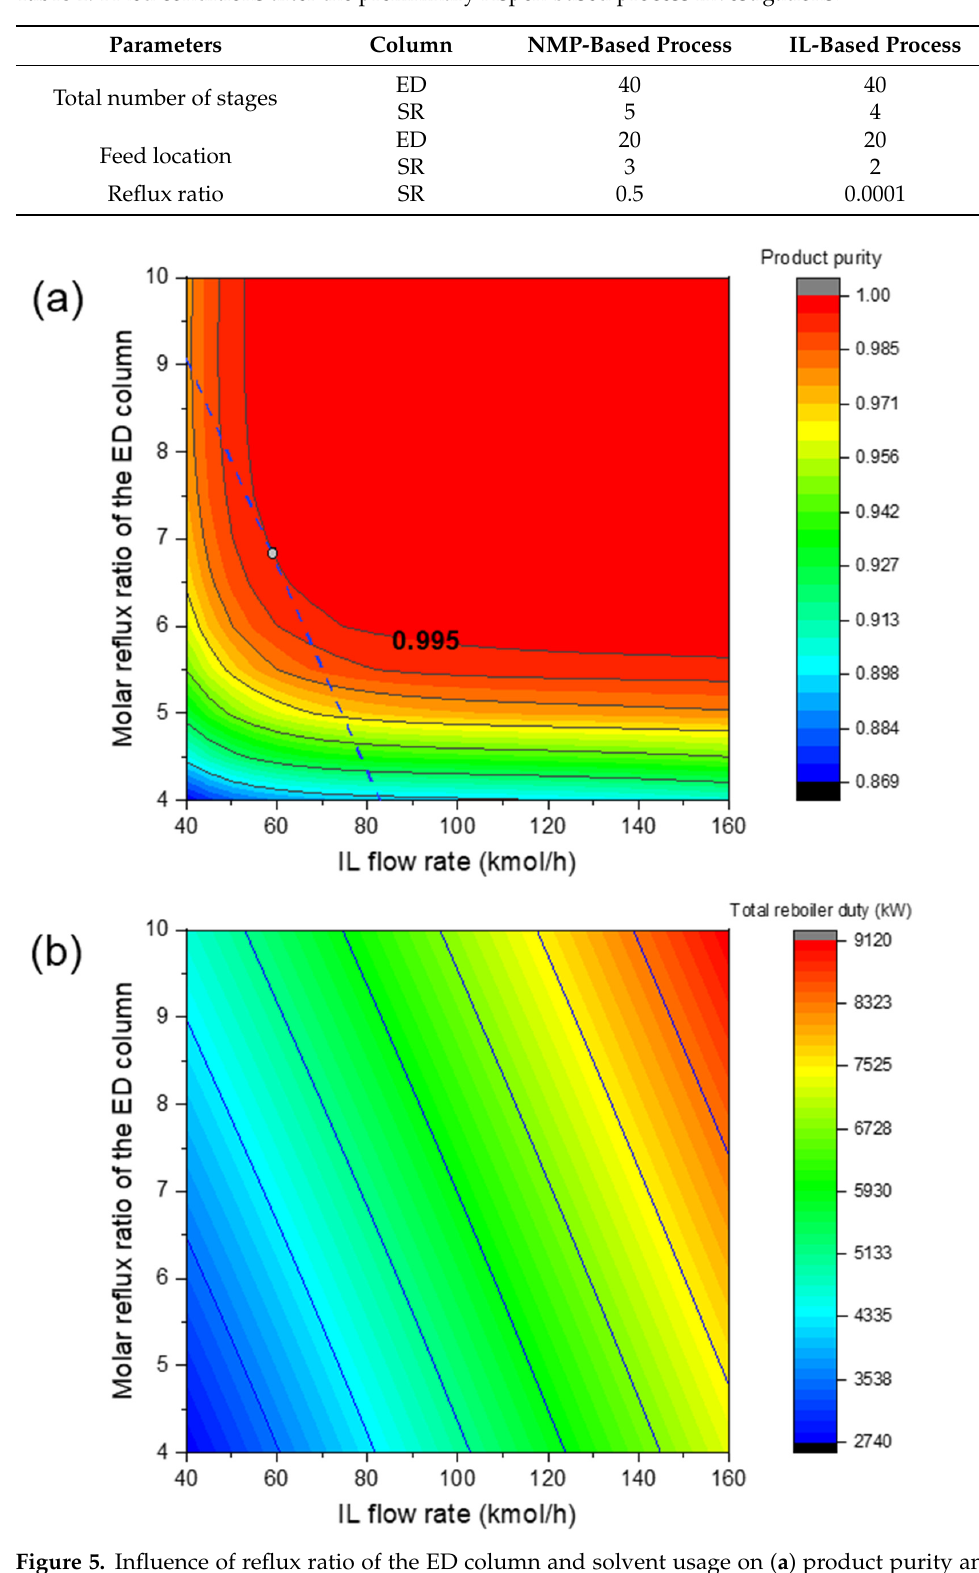
Table 1. Fixed conditions after the preliminary Aspen-based process investigations.